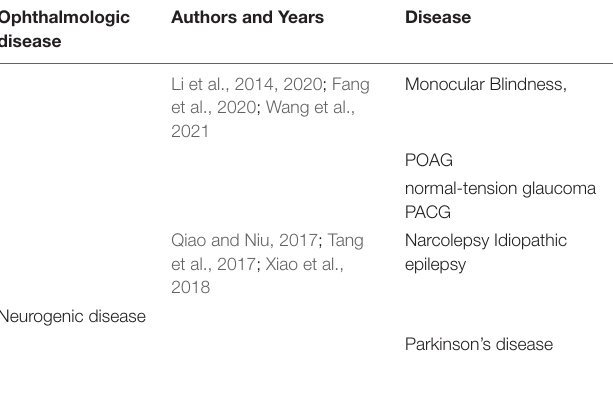
TABLE 3 | fALFF method applied in ophthalmologic and neurogenic disease. Ophthalmologic